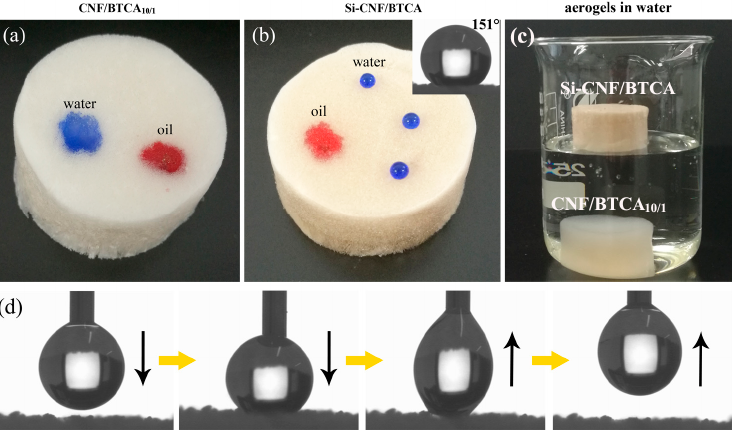
Figure 2. The wettability of oil and water on the CNF/BTCA 10/1 aerogel ( a ) and Si-CNF/BTCA aerogel ( b ). ( c ) Photograph of CNF/BTCA 10/1 and Si-CNF/BTCA aerogels in water. ( d ) Photographs of the contact process between the water droplet and Si-CNF/BTCA aerogel.